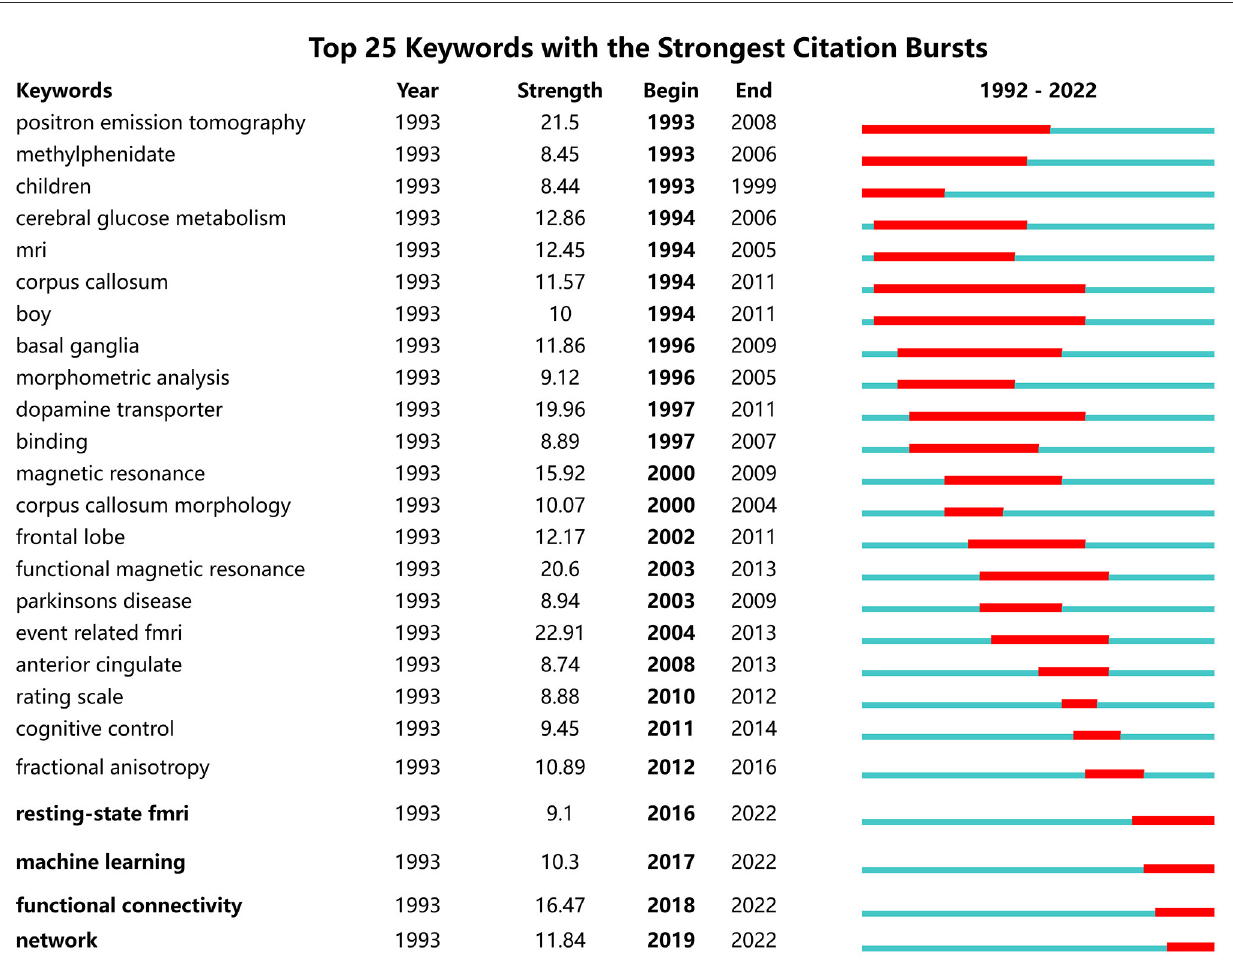
FIGURE9 Top 15 keywords with the strongest citation